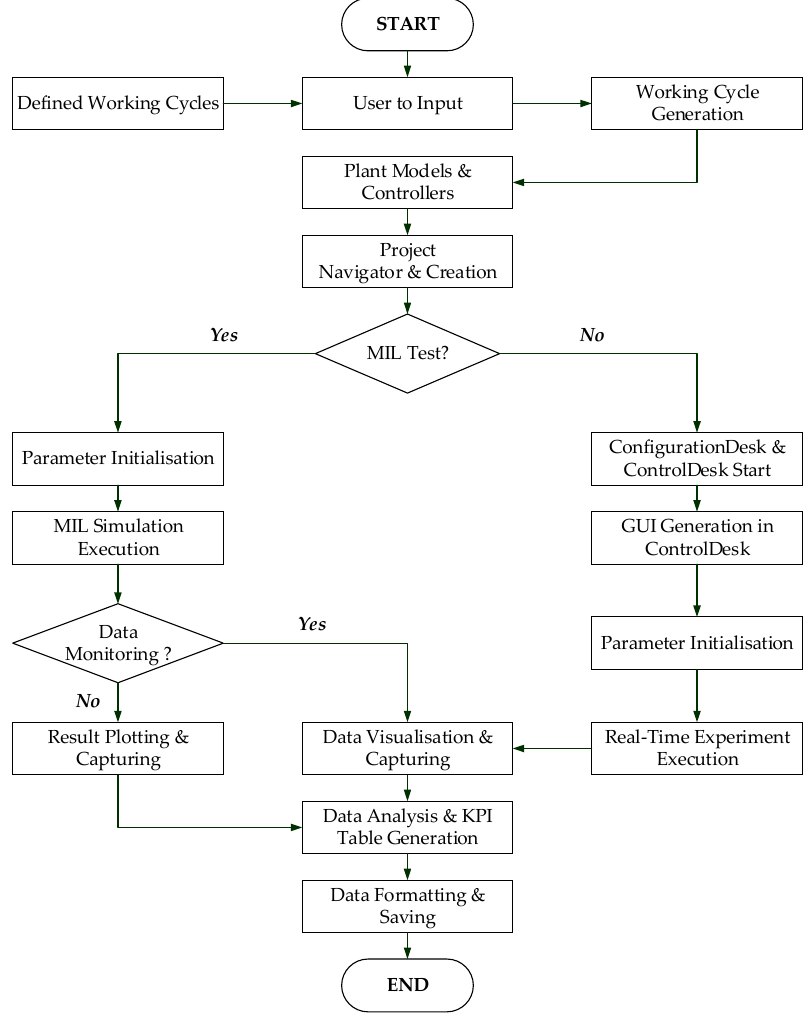
Figure 9. Working principle of the simulation tool chain.